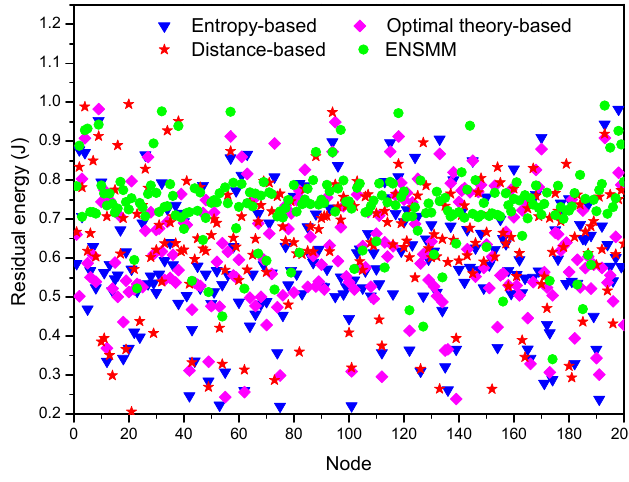
Figure 11. The residual energy of each node under different algorithms.